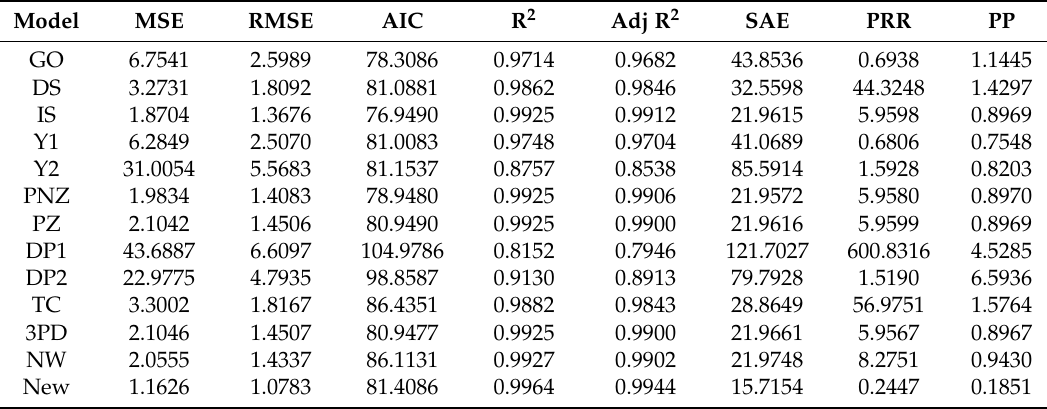
Table 8. Comparison criteria from TS dataset (Dataset